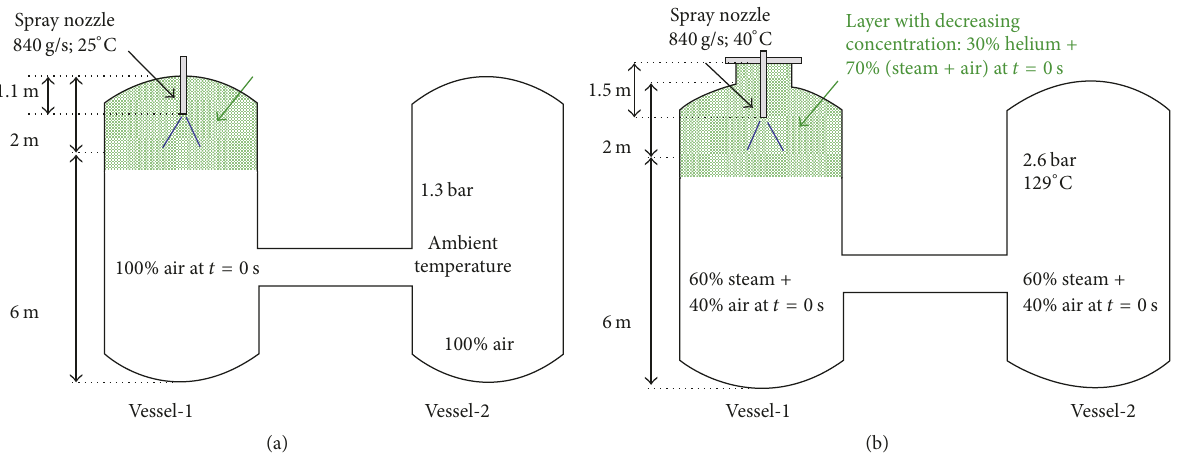
Figure 18: Schematic view of PANDA facility, initial and boundary conditions for ST3 0 (a) and ST3 2 (b)